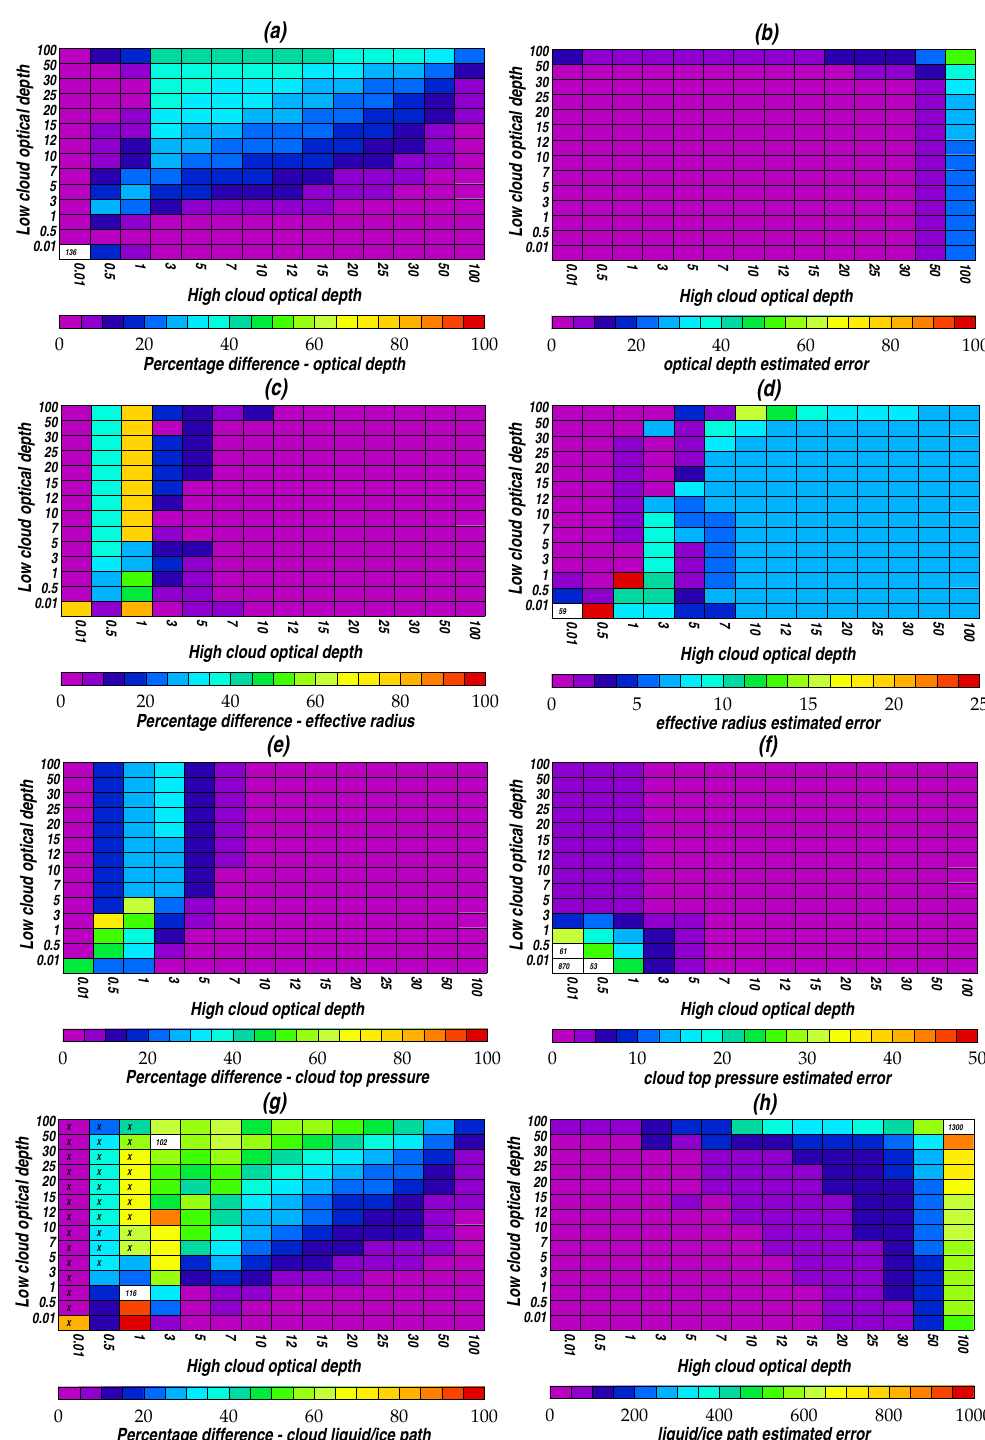
Fig. 5. Plots showing the percentage differences between the “true” and retrieved cloud parameter, left column, compared to the retrieval error for the cloud parameter, right column. From top to bottom the results are shown for optical depth, effective radius, cloud top pressure and cloud liquid/ice path. The ‘truth’ is defined by the phase selected. The “X” in plot (g) denotes when a liquid phase was selected as the retrieval with the lowest cost as per Fig.